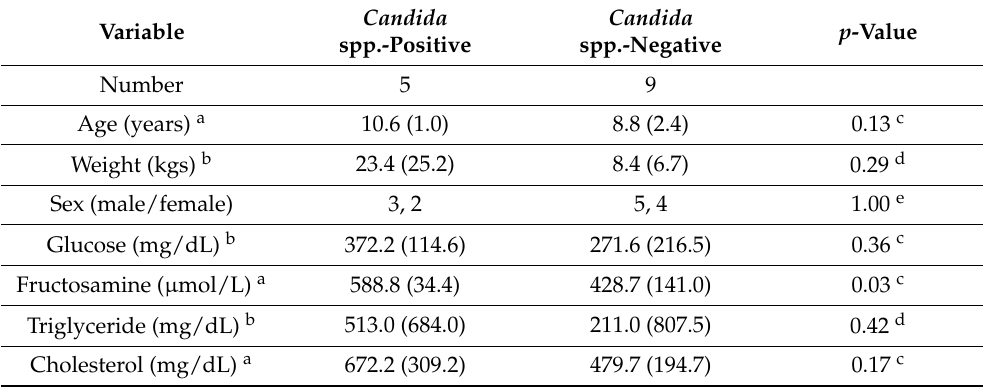
Table 6. Comparative descriptive and clinicopathologic features of dogs with naturally occurring diabetes mellitus with and without Candida spp. colonization from fecal cultures.